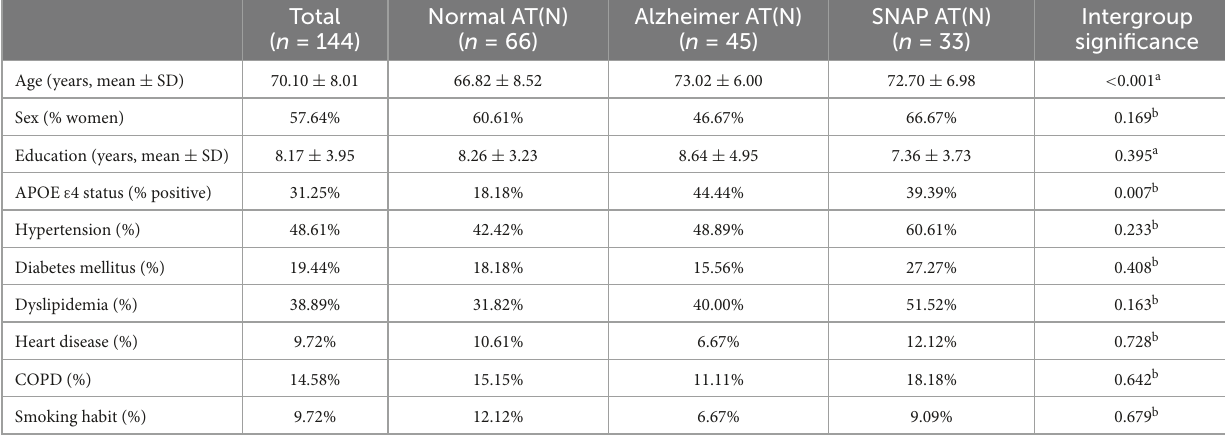
TABLE 1 Demographic and clinical characteristics of the